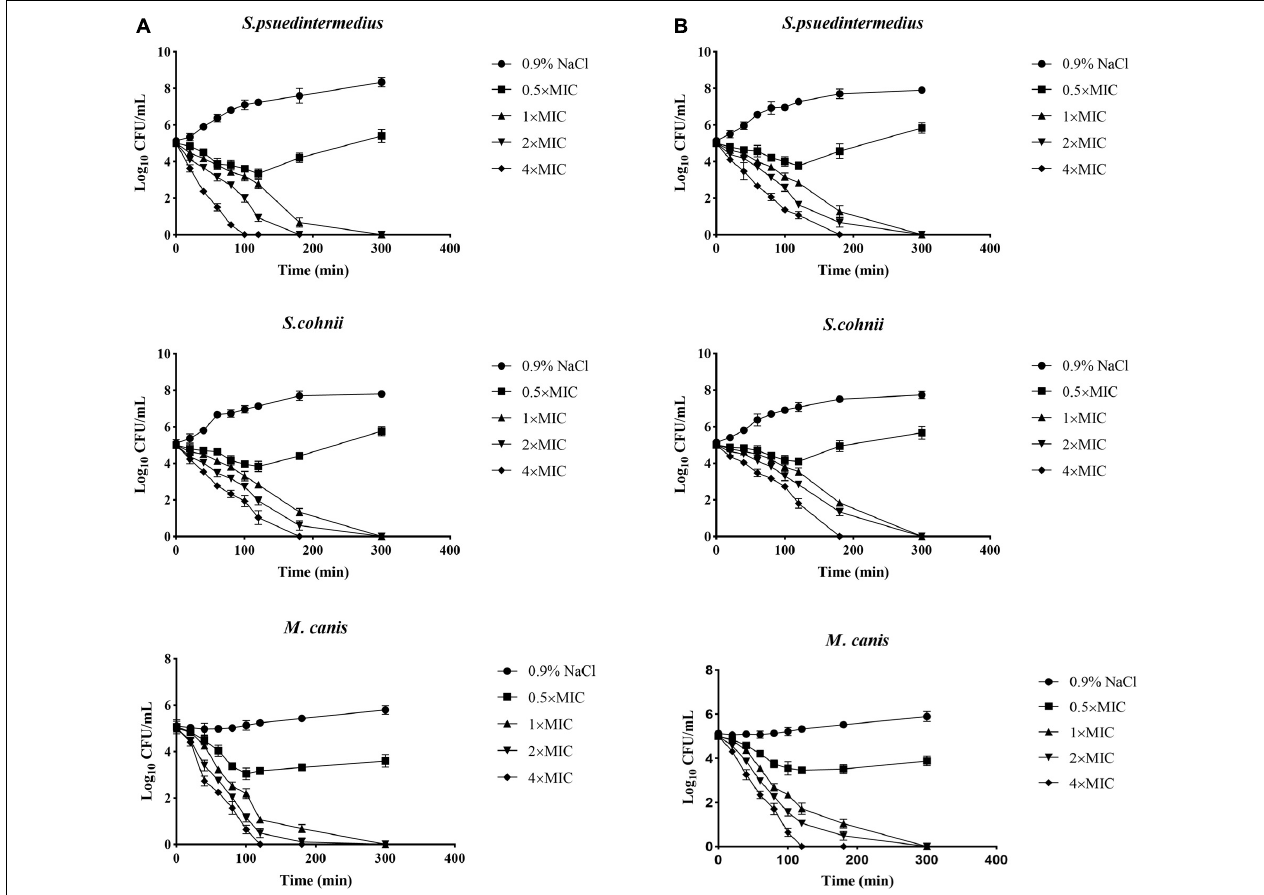
FIGURE 2 | Microbial killing kinetics of allomyrinasin (A) and andricin B (B) against Staphylococcus pseudintermedius MW767056, Staphylococcus cohnii MW767053, and Microsporum canis MW768151 at four different concentrations. Inocula treated with physiological saline (0.9% NaCl) were used as a control. The error bars represent the standard deviation (SD) for three